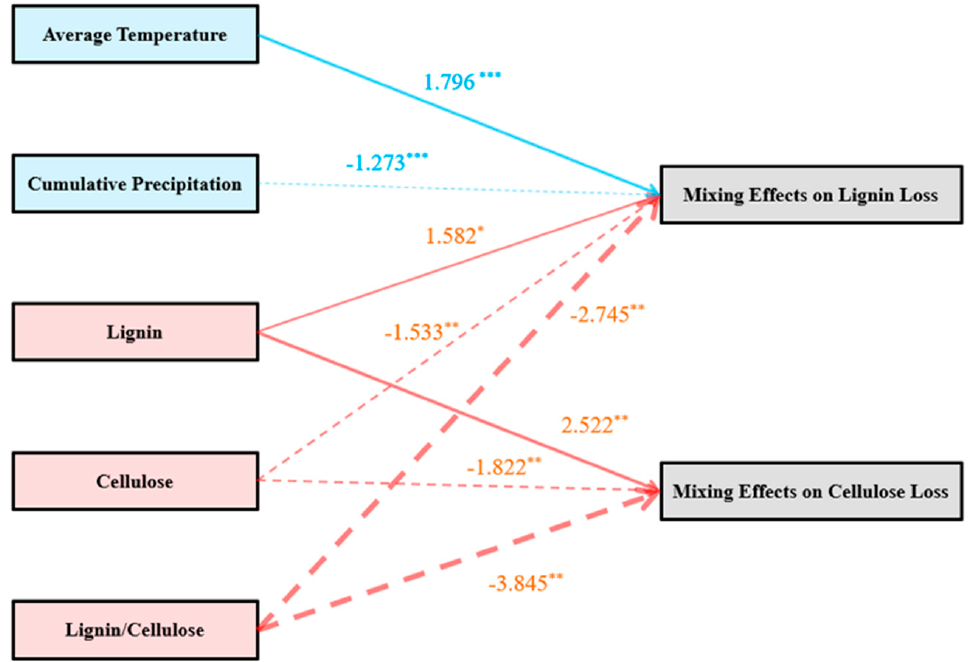
Figure 6. Path diagram showing the relationships among changing chemical traits and environmental factors and the mixing effects on lignin and cellulose loss. Line widths indicate the relative strengths of the paths. Solid and broken lines represent positive and negative effects, respectively. Significance: * p < 0.05; ** p < 0.01; *** p < 0.001.